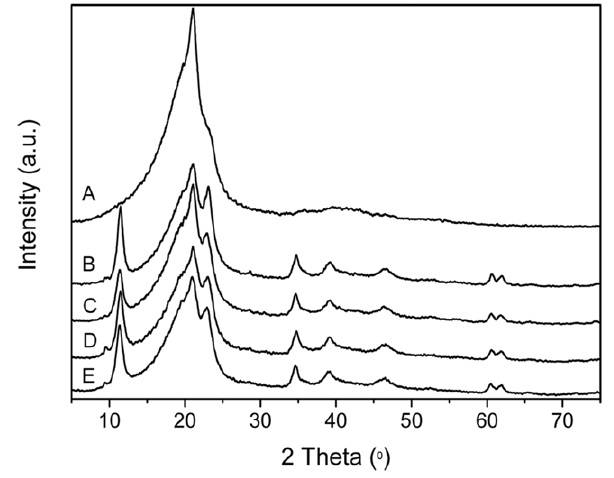
Figure 6. XRD patterns for the pristine EVA and LDHs/EVA composites with a loading of 20 wt% LDHs. A: the pristine EVA, B: S-Ni 0.1 MgAl/EVA, C: S-Ni 0.1 MgAl-Nd/EVA, D: S-Ni 0.1 MgAl-Ce/EVA and E: S-Ni 0.1 MgAl-La/EVA.